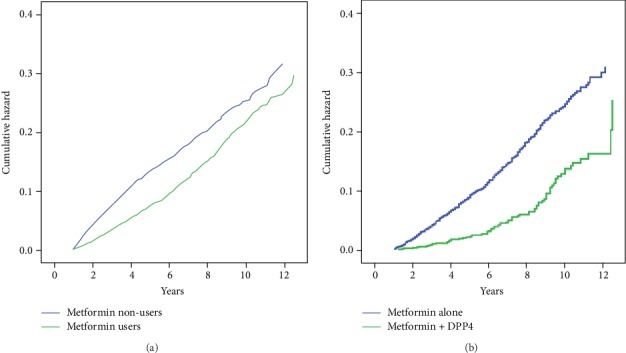
(a) Cumulative hazard of NPDR: comparison between metformin users and nonusers with DM. (b) Cumulative hazard of NPDR: comparison between metformin alone users and metformin + DPP-4i users with DM.